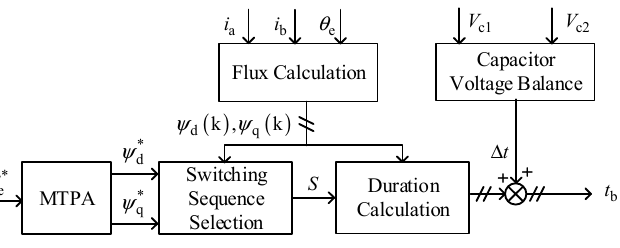
Figure 8. Control diagram of the switching sequence MPDTC.